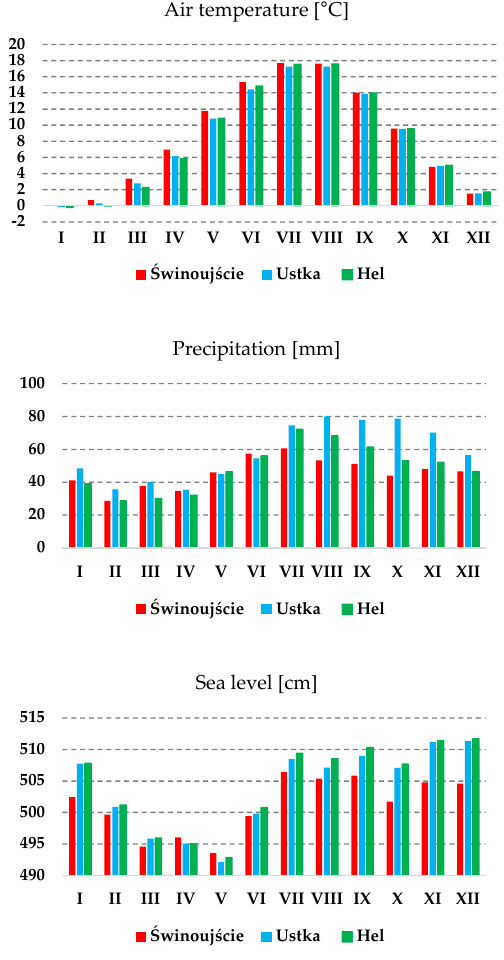
Figure 2. Average monthly values for air temperature, atmospheric precipitation, and sea level in Świnoujście, Ustka, and Hel from 1966–2015.